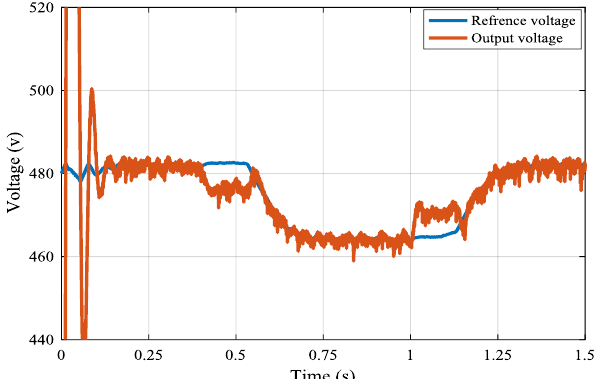
Figure 11. Following the reference voltage by output voltage.